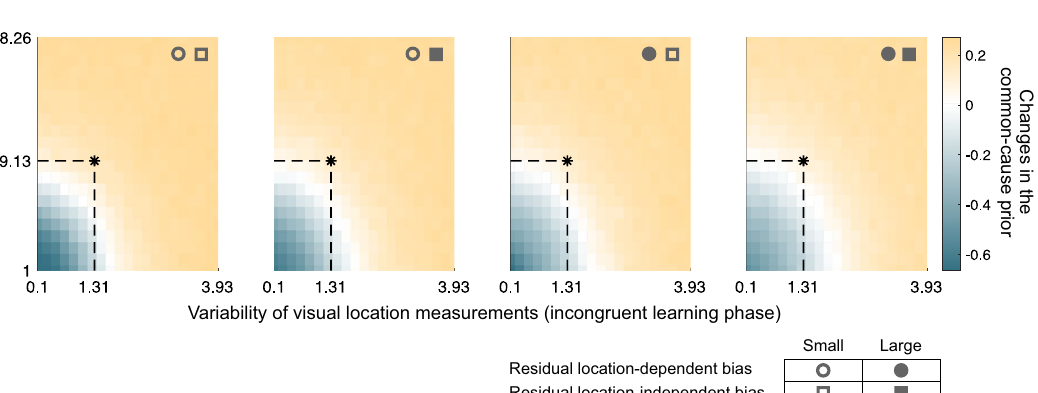
Figure 6. Simulation results. ( A ) Influence of the variability of auditory (blue) and visual (red) location measurements on the posterior probability of a common cause. Shaded area: ±SD. Both uncertainties increase along the horizontal axis. Three pairs of auditory and visual likelihood functions are simulated, ranging from relatively low (orange), to medium (green), and high (purple) variability of both sensory measurements. ( B ) Influence of the distance between auditory and visual location measurements on the posterior probability of a common cause. Three pairs of auditory and visual likelihood functions are simulated, from perfectly aligned measurements (orange), to close proximity (green), and highly discrepant measurements (purple). ( C ) Accumulated updates of the common-cause prior, averaged across 100 simulations of the congruent learning phase, as a function of visual (x-axis) and auditory (y-axis) measurement variability. Each panel shows a different residual misalignment of auditory relative to visual spatial perception. Open/filled circles represent small/large residual location-dependent bias (0.75/0.5 times the mean estimated location-dependent bias); ◦ / 6 ◦ open/filled squares represent small/large residual location-independent bias (the bias is 3 more leftward compared to the mean estimated location-independent bias); asterisks and dashed lines represent group means of the estimated measurement variability, which was assumed to be the same across the pre- and post-learning phases. ( D ) Simulated accumulated updates of the common-cause prior after the incongruent learning